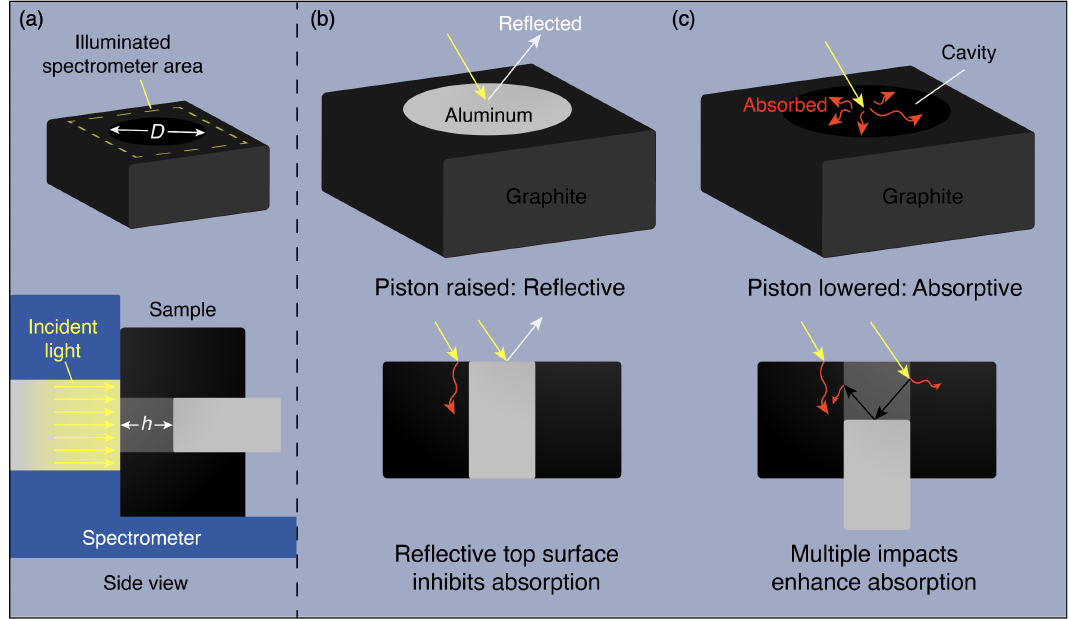
Figure 1. ( a ) Schematic view of spectrometer test setup, showing geometry defined by diameter D and displacement h . The side view illustrates the orientation of the spectrometer with respect to the sample. Schematic concepts of piston-like actuation for dynamic thermal radiation tuning (cross-sectional view) in ( b ) raised (reflective) and ( c ) lowered (absorp- tive) positions. Employing dissimilar materials and modifying the overall shape factor induces significant changes in optical